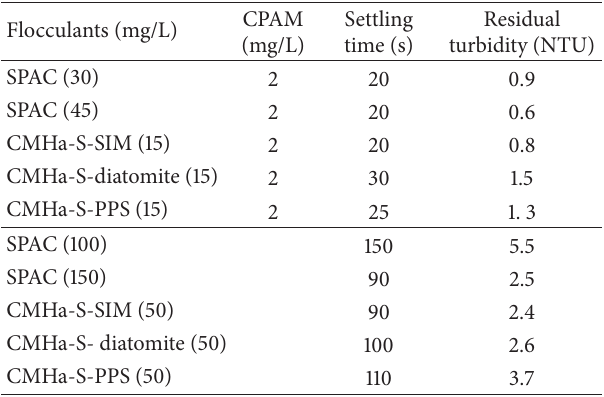
Table 10: CMHa-S with different carried dosage of PDMDAAC. Samples